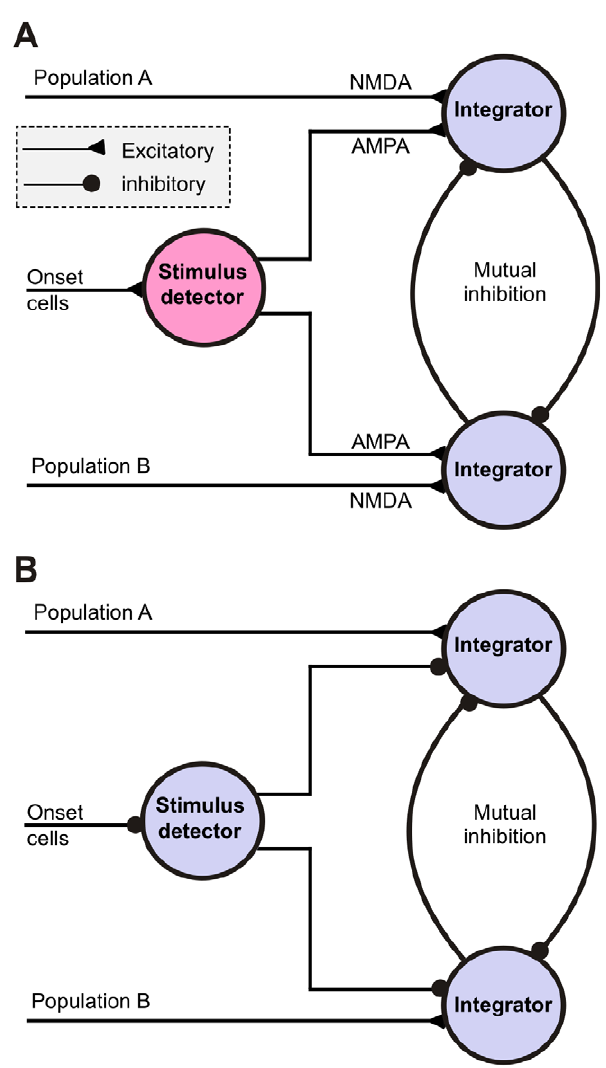
Figure 10. Neuronal architectures for implementing the tWTA readout for a two-alternative task. The figure describes in a qualitative manner neuronal architectures that can implement the tWTA readout in the context of a two-alternative task. The inputs from population A and population B represent the two alternatives. Both architectures rely on reciprocal inhibition for implementing a ‘race to threshold’ competition but they differ in the implementation of the gating mechanism (see Discussion for details). (A) Implementation of the gating mechanism using NMDA synapses. (B) Implementation of the gating mechanism using